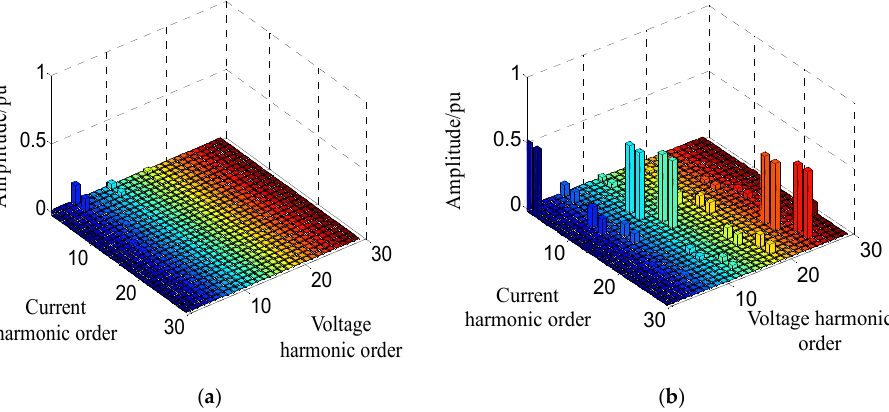
Figure 4. Negative sequence harmonic coupled admittance matrix elements of parallel 12-pulse rectifier. ( a ) Matrix Y − ; ( b ) Matrix Y −∗ .